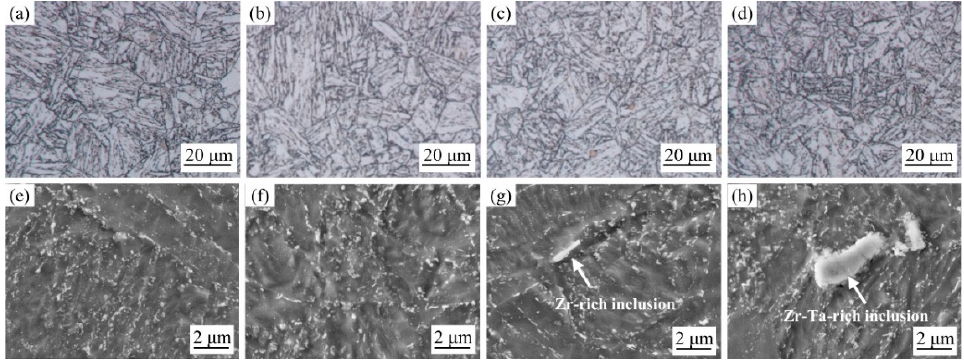
Figure 2. Microstructure of tempered steels. ( a – d ) OM, ( e – h ) SEM, ( a , e ) 0ZrA, ( b , f ) 0.004ZrA, ( c , g ) 0.037ZrA, and ( d , h ) 0.098ZrA.